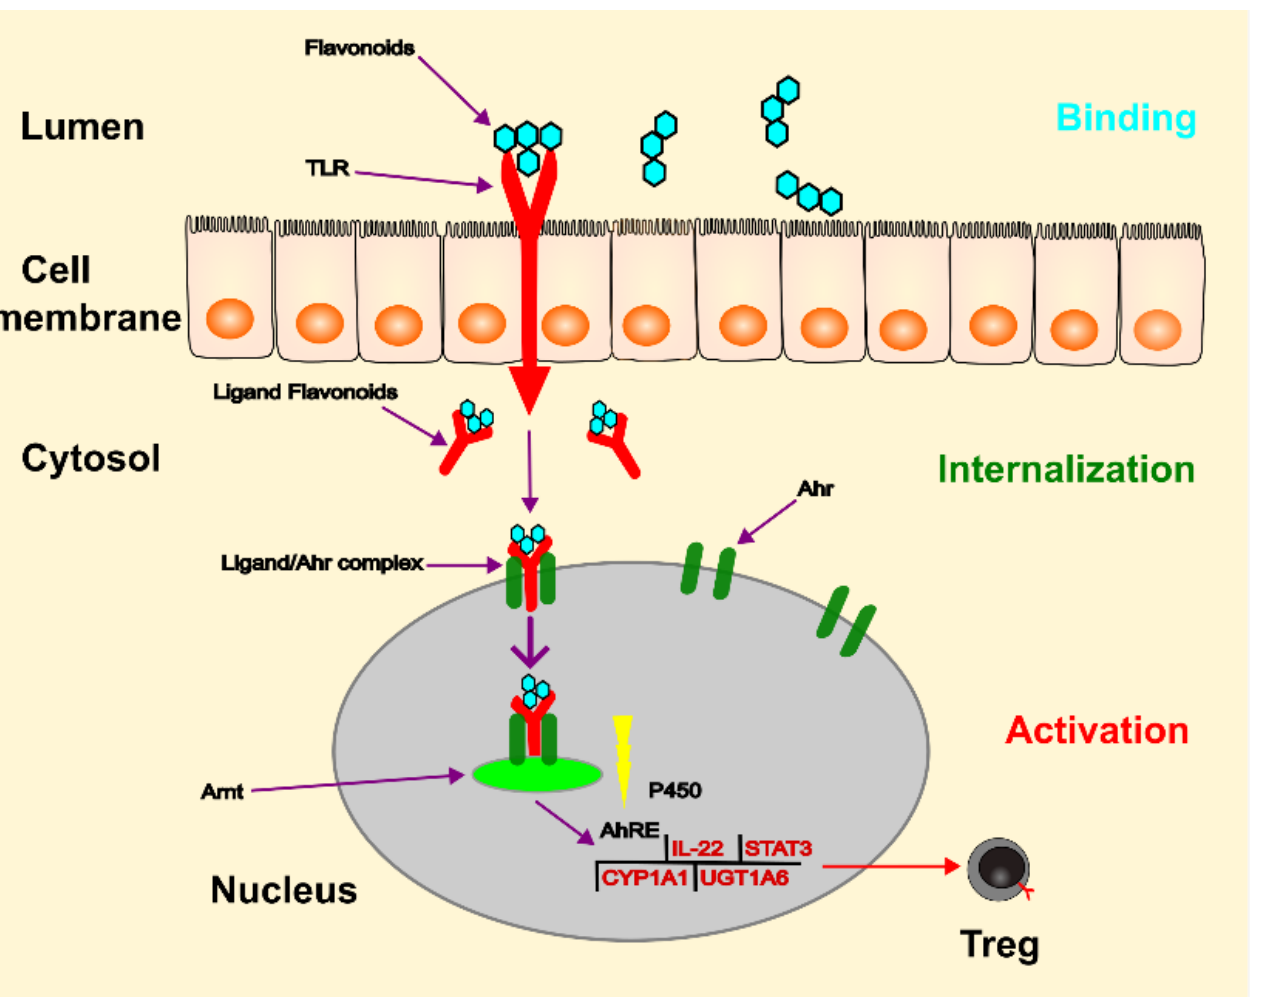
Figure 4. The process of gene regulation by Ahr can be simplified as follows: flavonoids bind to TLR in the lumen and are then internalised into the cytosol. This complex acts as a ligand for Ahr, leading to the release of associated proteins and translocation of the complex to the nucleus. Ahr then dimerises with Arnt and the Ahr/Arnt complex binds to the AhRE, triggering transcription of target genes. This process leads to increased production of IL-22 and cytochrome P-450, and decreased production of STAT3 and NF- κB. The ligands can also act on the cytoplasm by altering the function of various proteins through a cascade of protein phosphorylation facilitated by AhR-associated protein kinases. (Ahr: aryl hydrocarbon receptor; TLR: toll-like receptor; Arnt: Ahr nuclear translocator;